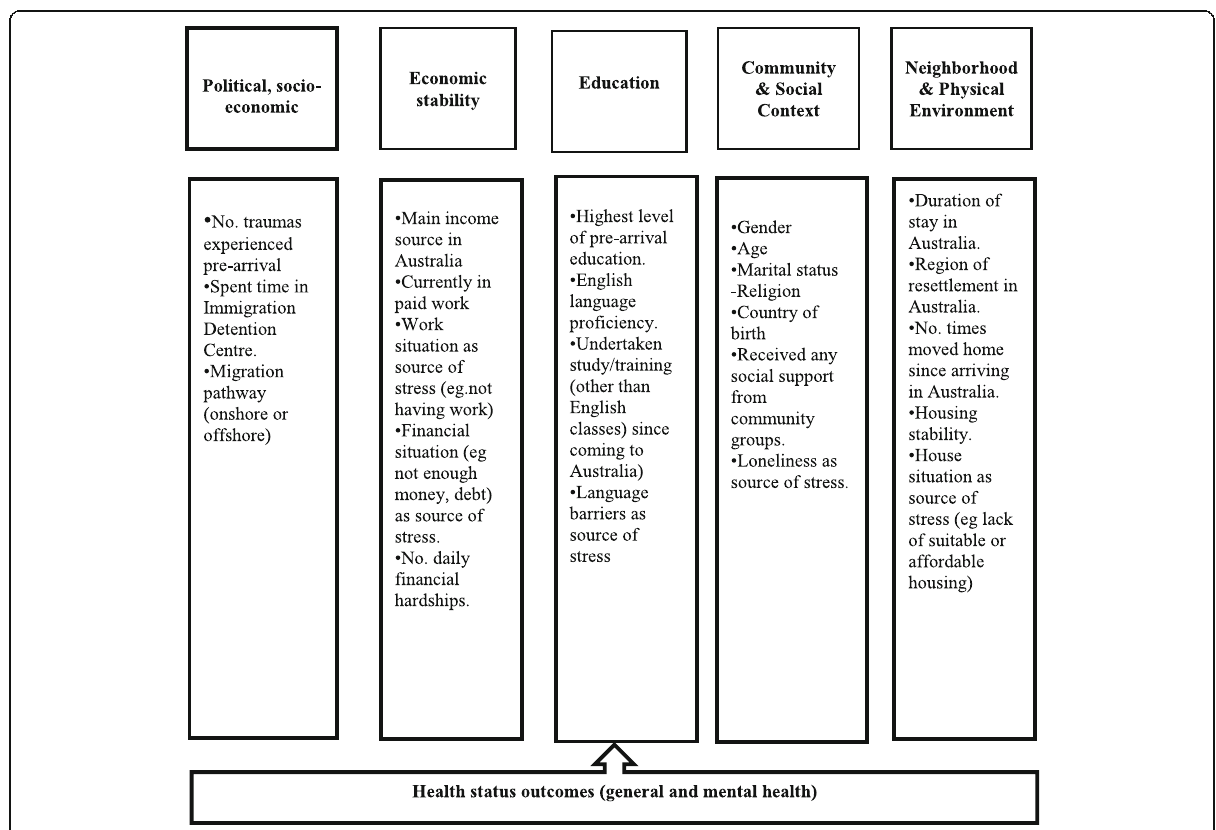
Fig. 2 Conceptual framework for the social determinants of health in resettled refugee